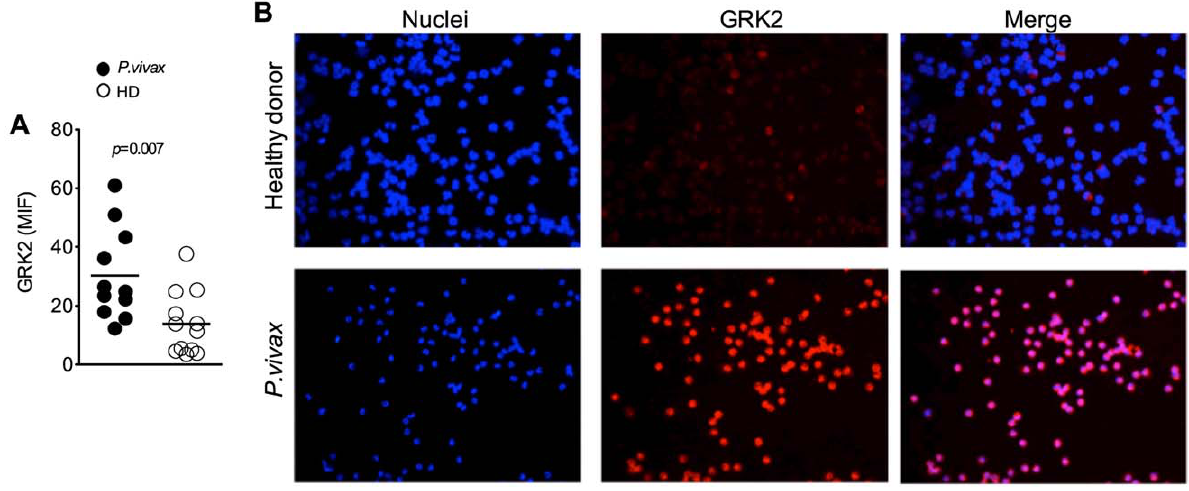
Figure 6. GRK2 expression is enhanced in neutrophils during acute malaria. Neutrophils isolated from P. vivax -infected patients (closed circles; n=11) or healthy donors (closed circles; n=12) were stained for GRK2 and mean fluorescence intensity (MFI) of GRK2 was quantified (A). Representative fluorescence microscopy illustrating GRK2 expression in neutrophils from a healthy donor and a P. vivax -infected patient (B). Significant difference is indicated with p -values using unpaired t